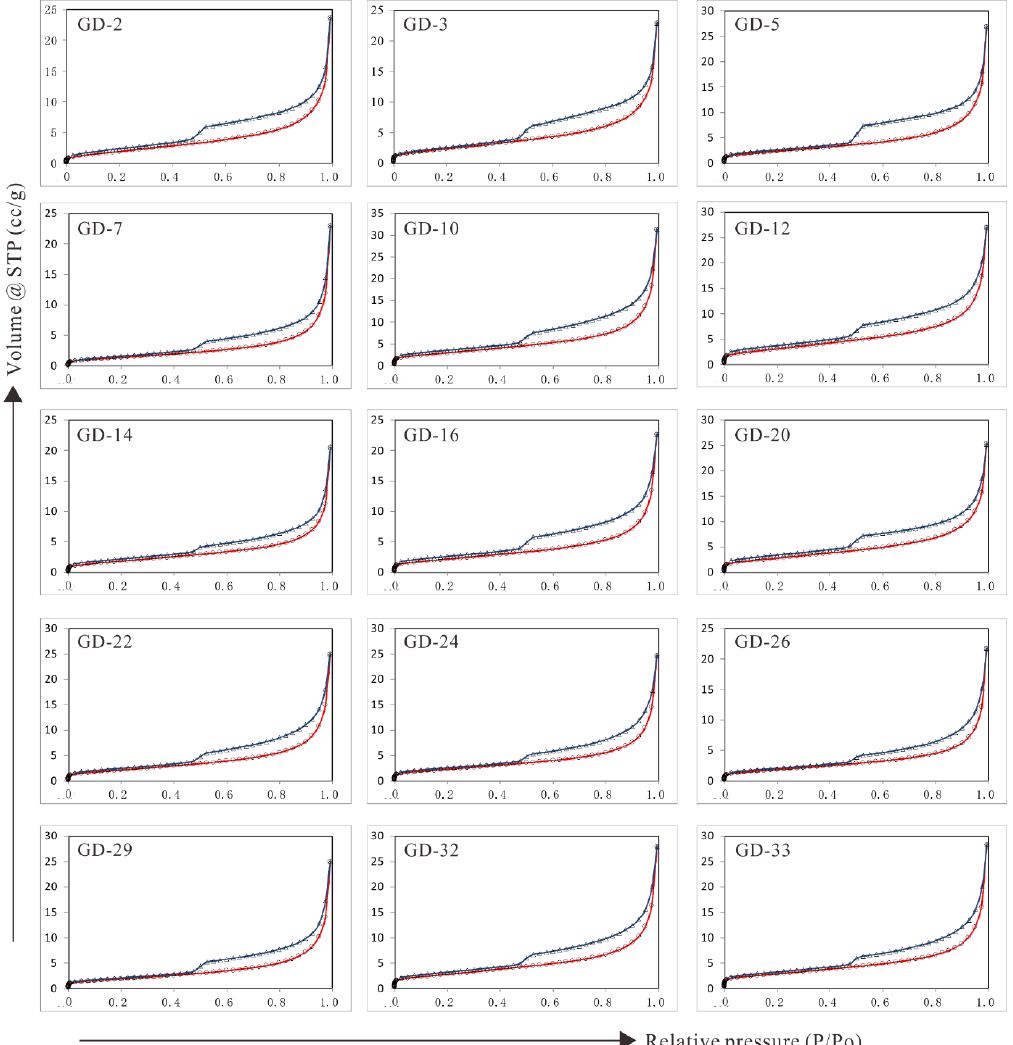
Figure 6. N 2 adsorption–desorption isotherms of the Permian Dalong Formation shales.